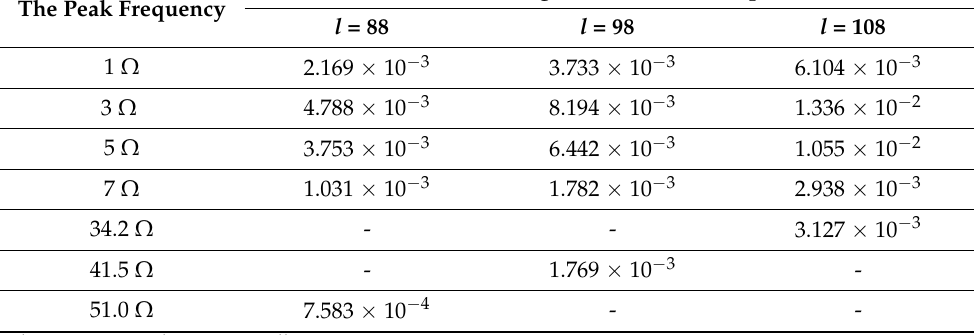
Table 5. The peak amplitude of the lateral vibration spectrum of the follower output node D where Ω = 320 rad/s and with three follower rod lengths. Three Follower Rod Lengths (mm) (Peak Amplitude Unit: The Peak Frequency